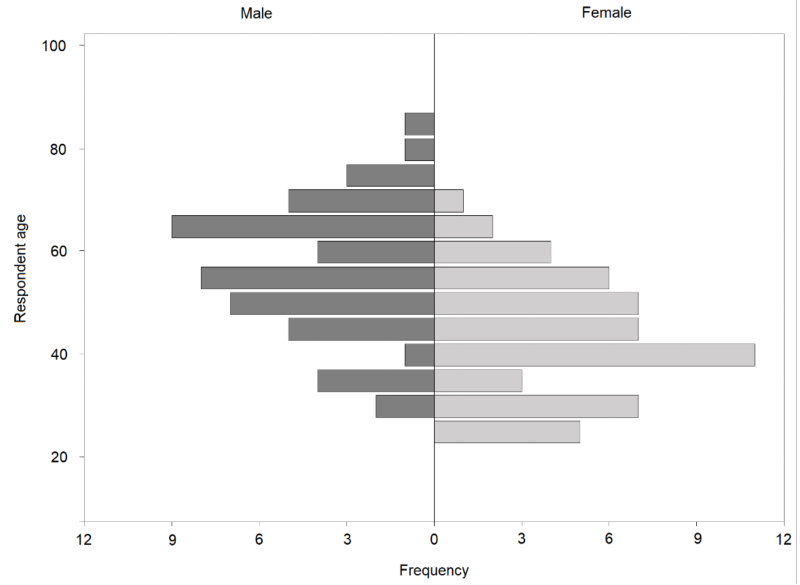
Figure 1. Gender and age distribution of veterinary